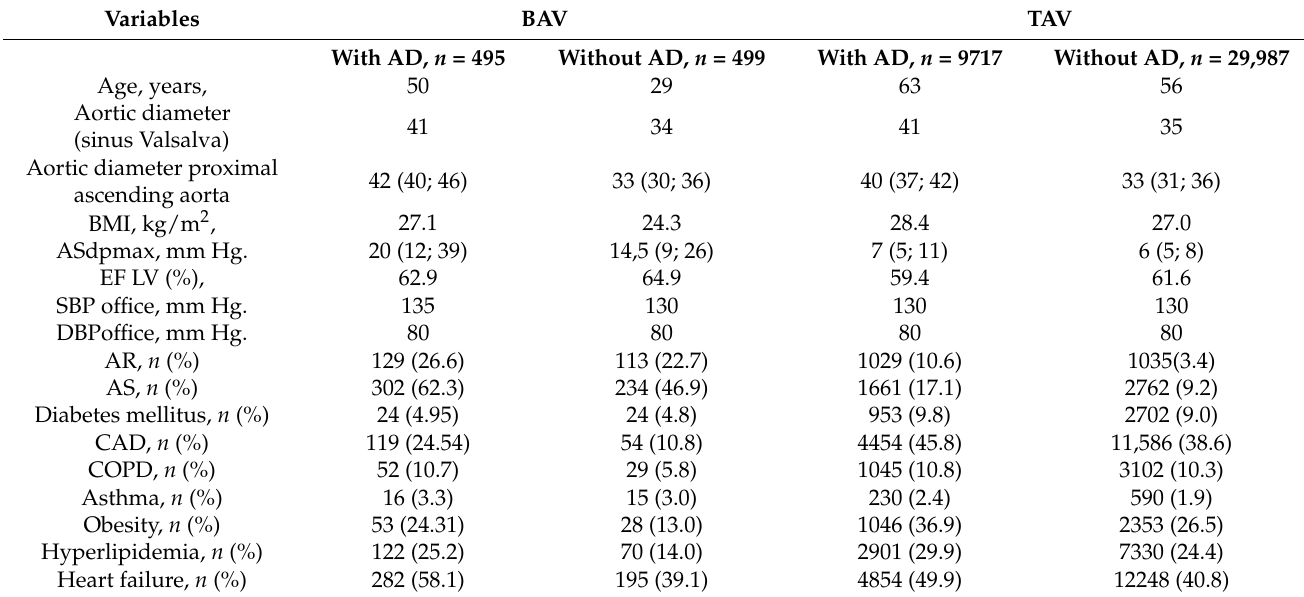
Table 5. Demographic and clinical characteristics of male patients.